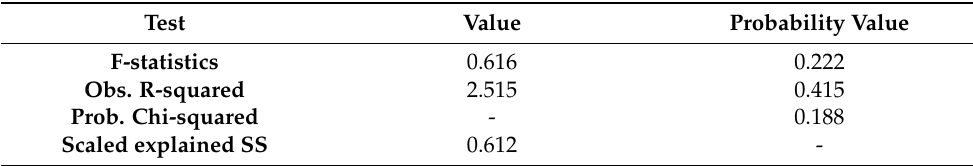
Table A2. Heteroscedasticity Test Breusch–Pagan–Godfrey